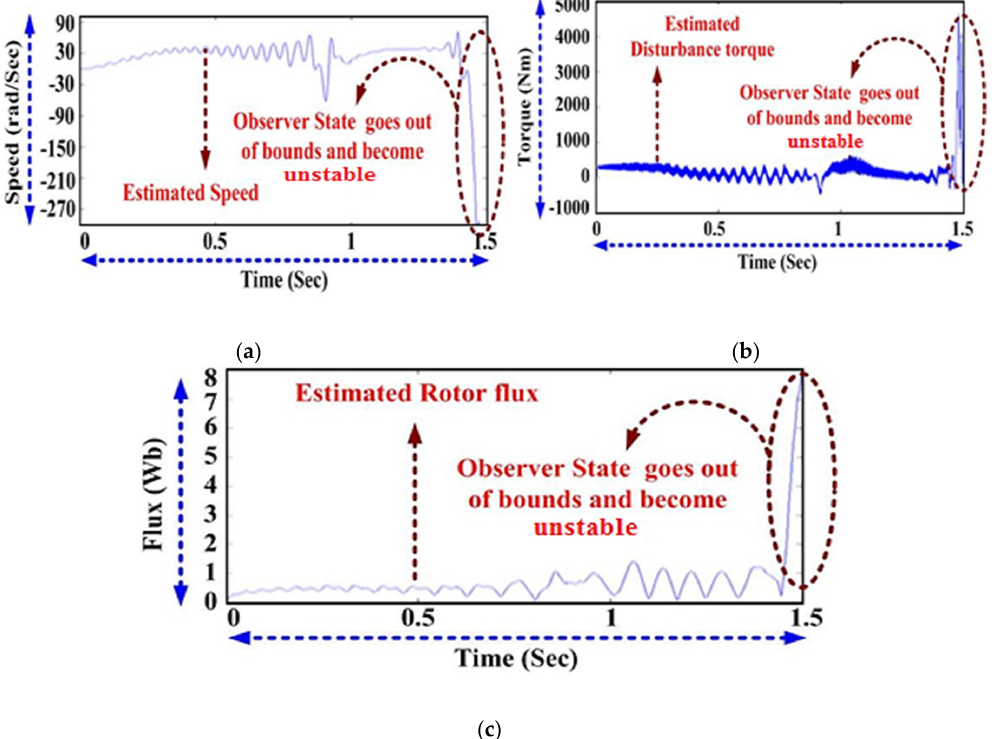
Figure 11. SMLO1: ( a ) estimated speed, ( b ) estimated torque and ( c ) estimated rotor flux.